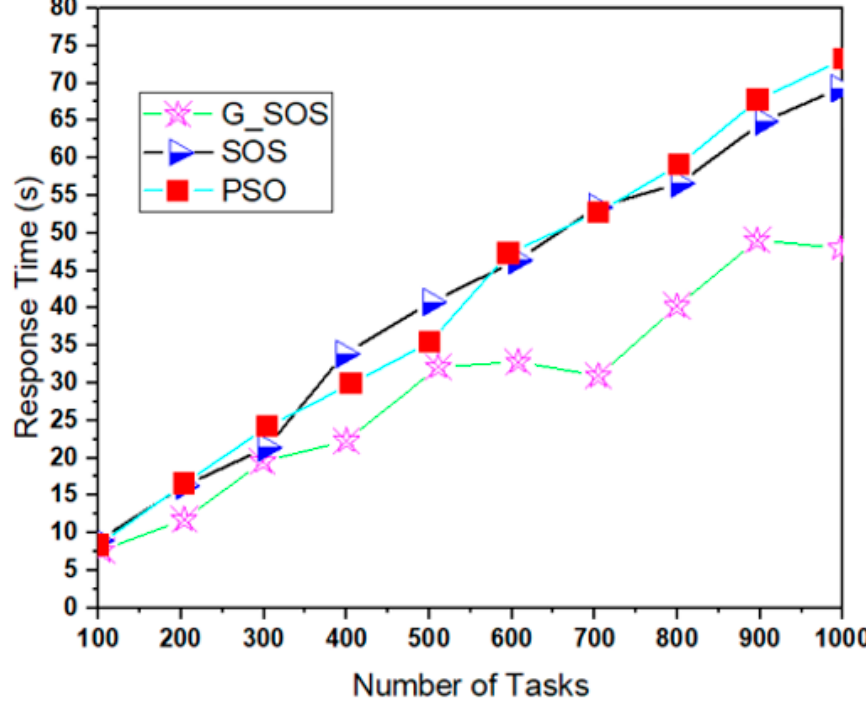
Figure 4. Response comparison between G_SOS, SOS and PSO (uniform distribution).